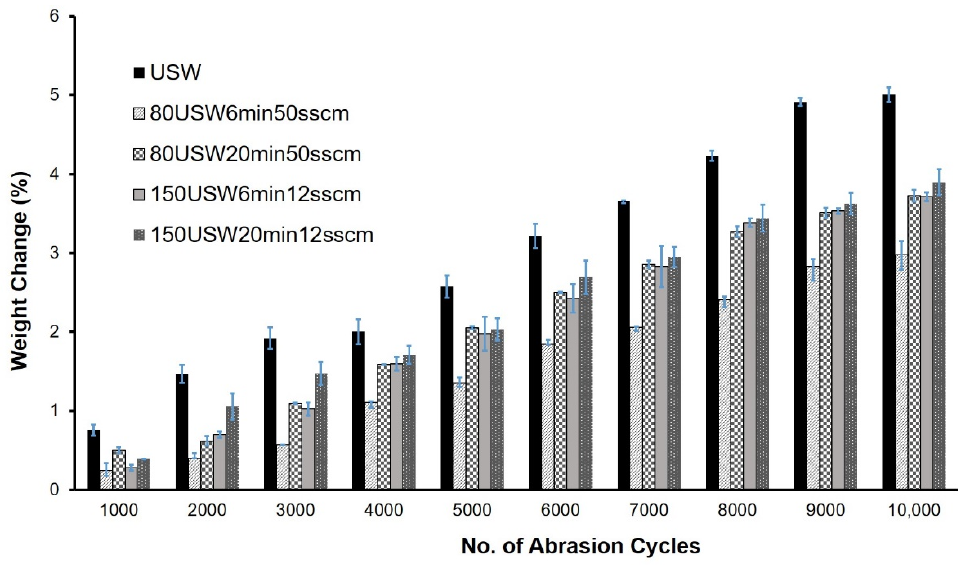
Figure 5. Weight loss of untreated and plasma-treated unscoured wool fabrics at different numbers of abrasion cycles.